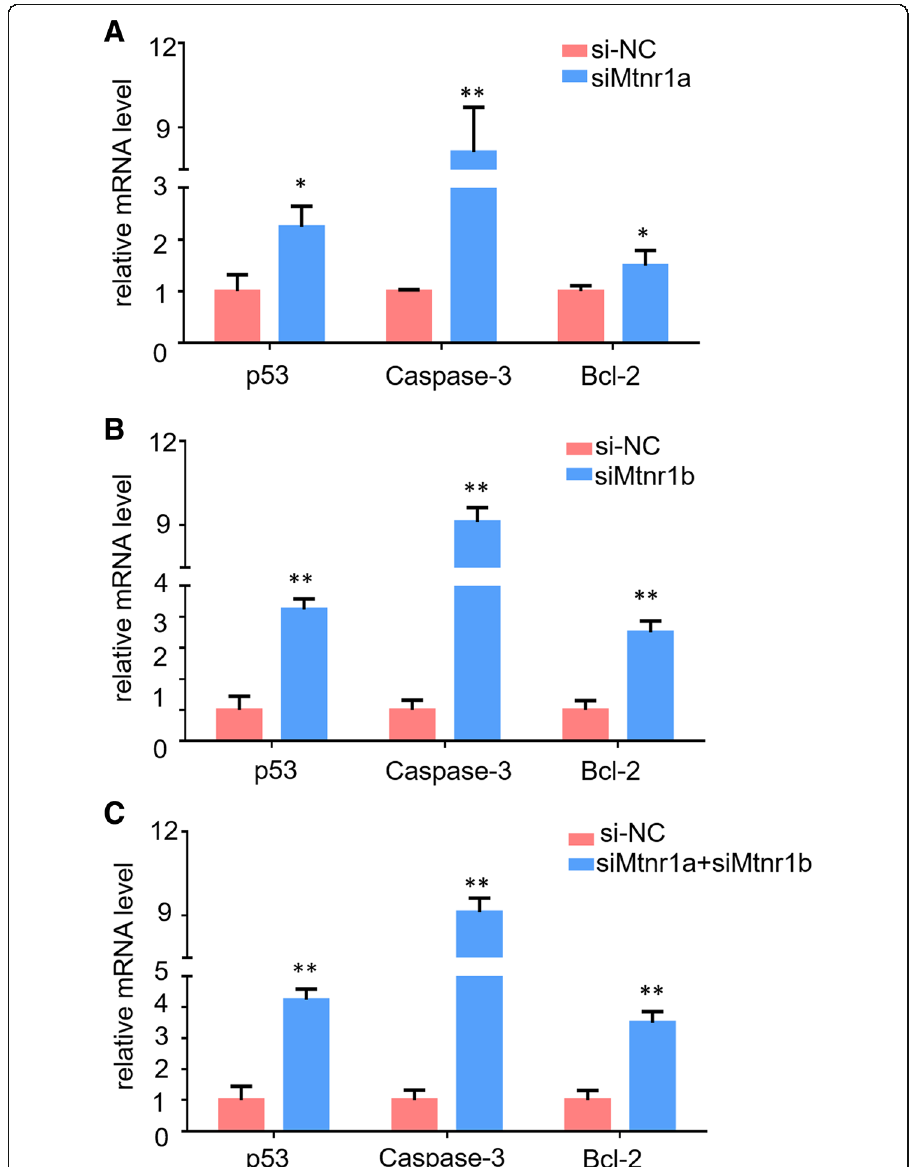
Fig. 6 Knockdown of MTNR1A and MTNR1B promotes apoptosis genes. a - c . Relative mRNA expression of cell apoptosis marker genes, Bcl-2, p53 and caspase-3, after treatment with the siRNAs against MTNR1A and MTNR1B for 48 h in mLTC-1. The mRNA expression level was normalized to that of Gapdh. Data are presented as the mean ± SEM of three triplicates. * P < 0.05, ** P < 0.01 (Student ’ s